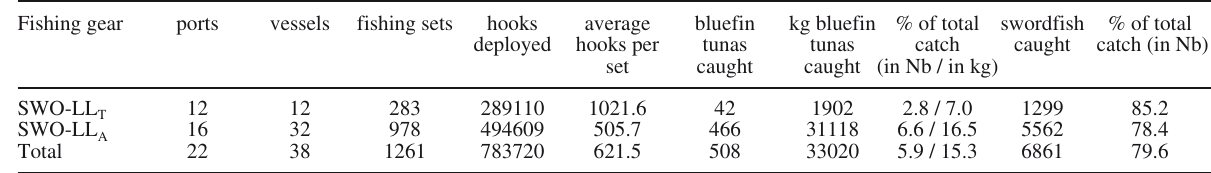
Table 1. – Number of ports, vessels, fishing sets, hooks deployed, bluefin tuna and swordfish caught by fishing gear in the eastern Mediter- ranean Sea swordfish long-line fishery, during 1998-2001 and 2003-2005 (ports and vessels overlap between fishing gears). Fishing gear ports vessels fishing sets